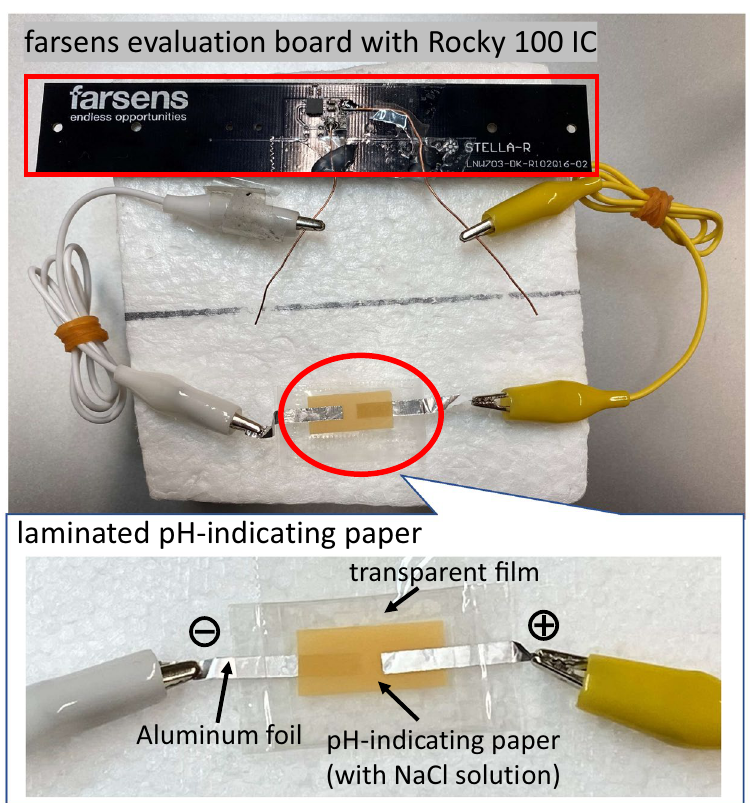
Figure 7. Fabricated prototype sample of color-change RFID tag that exploited an evaluation board (Stella-R) 28 of a Rocky 100 IC (Farsens) 29